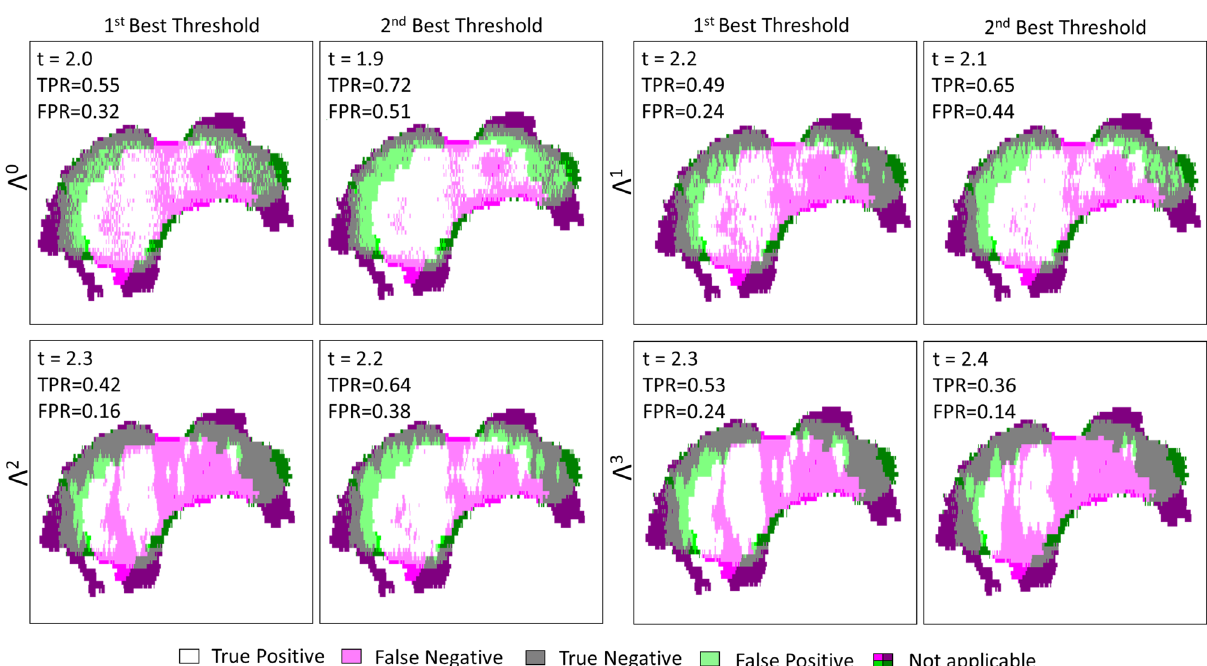
0 1 2 3 , (cid:31) , (cid:31) , (cid:31) and their respective first